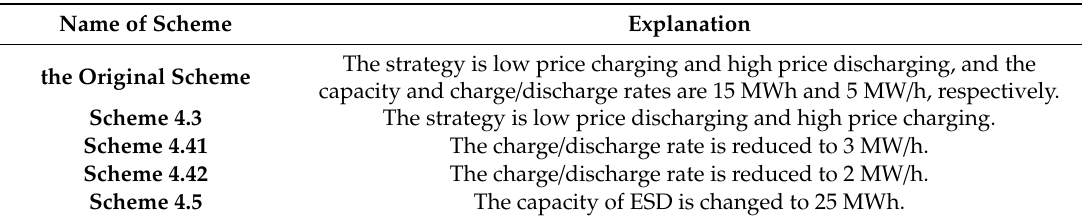
Table A1. Explanation of Scheme used in this